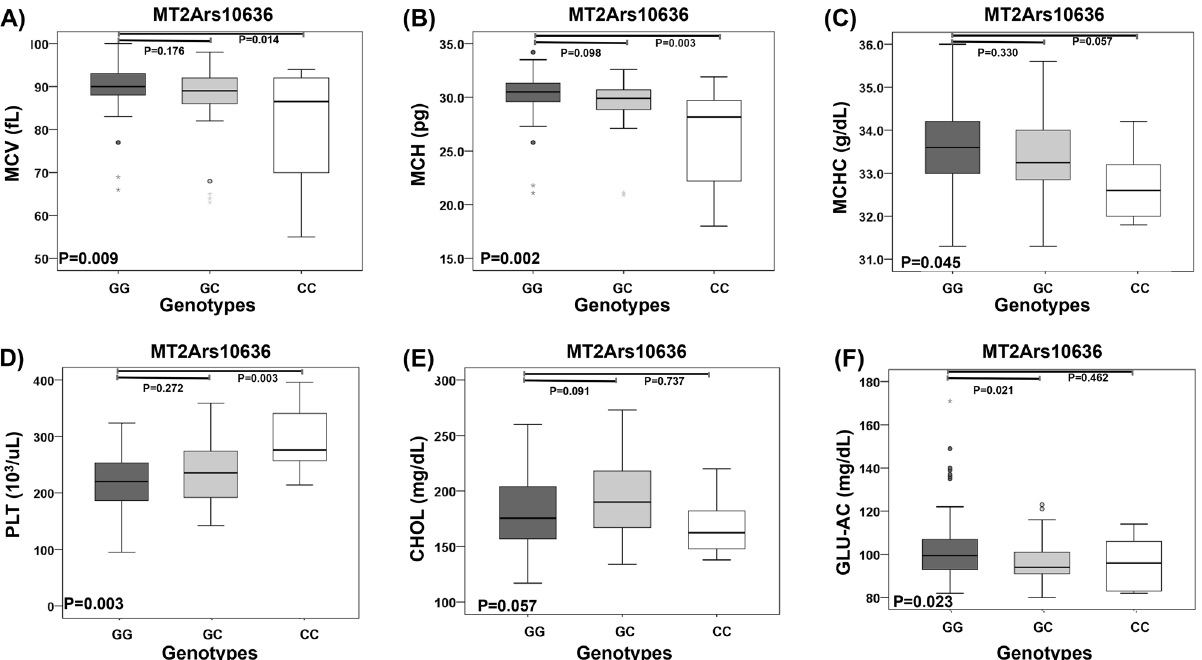
Figure 2. Associations of single point SNPs of MT2A with MCV, MCH, MCHC, PLT, CHOL, and GLU-AC. Data are expressed as mean ± SD. P value shows the comparison among three single point SNPs by ANOVA in the genotypes.